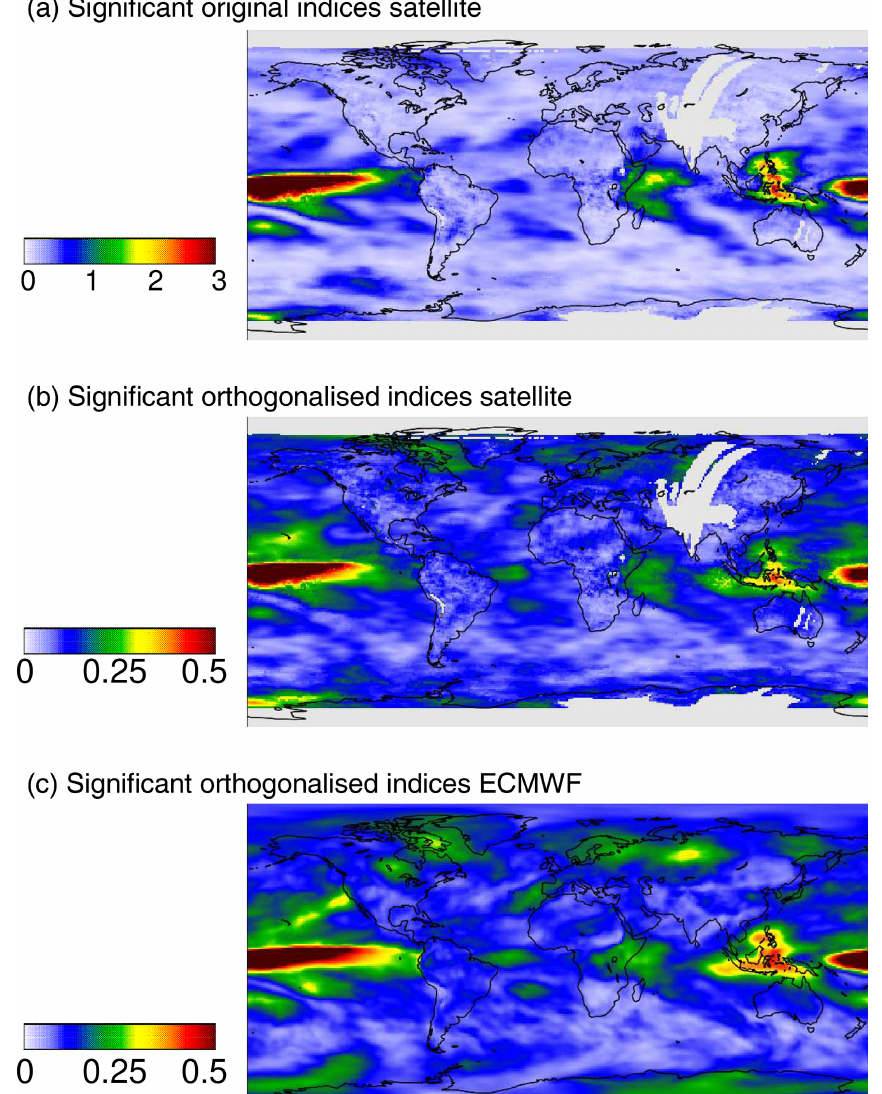
Figure 11. Cumulative delta rms for different selections of indices and data sets (note the different colour